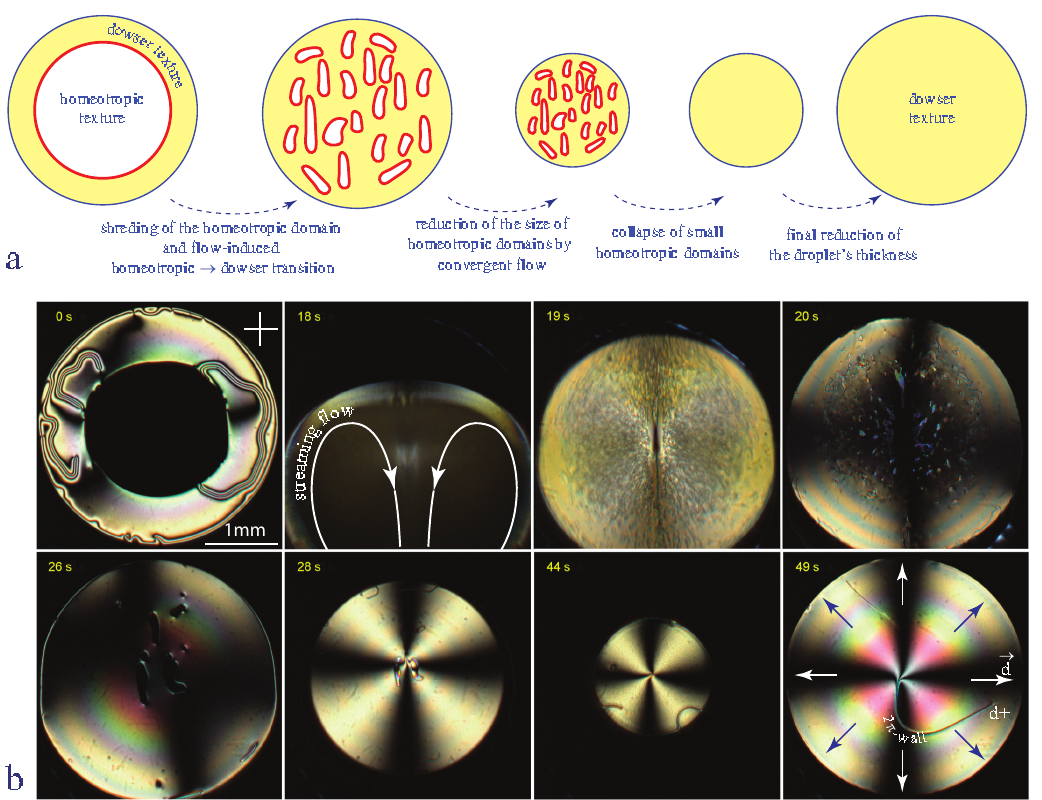
Dowser transformation accelerated by a streaming flow driven by Figure 6. Homeotropic ⇒ oscillations of the glass slide. (5CB)